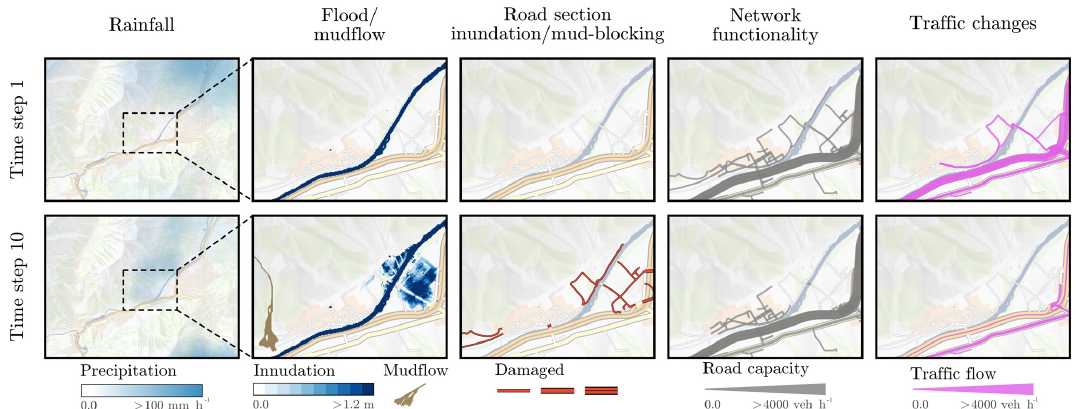
Figure 7. Spatio-temporal representation of the system. The columns represent the investigated events, while the rows illustrate different time steps of the considered scenario. Time step 1 represents the beginning of the simulation with all elements at their initial state. Time step 10 illustrates the system state close to the peak of the flood. As observed, road sections were damaged by the flood, which resulted in functional losses and a change of traffic flow. In this scenario, people living in the northern part of the area were cut off from the rest of the network due to severely inundated